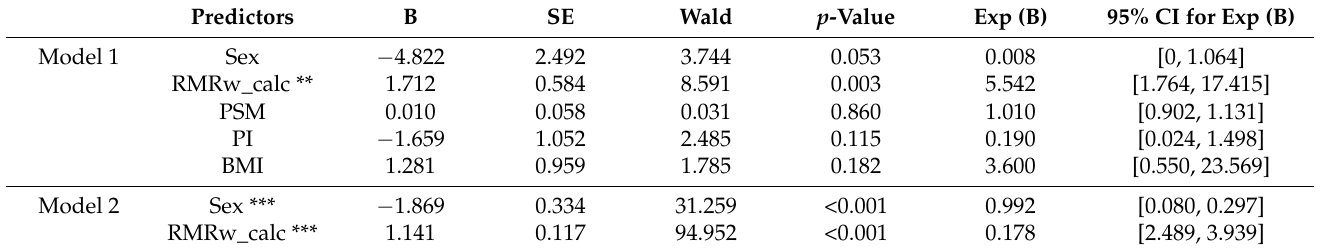
Table 4. Logistic regression analysis for the classification of Tae-Eum- and non-Tae-Eum-type groups.